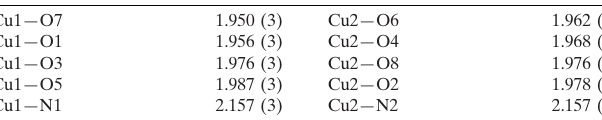
Selected bond lengths (A˚ ).